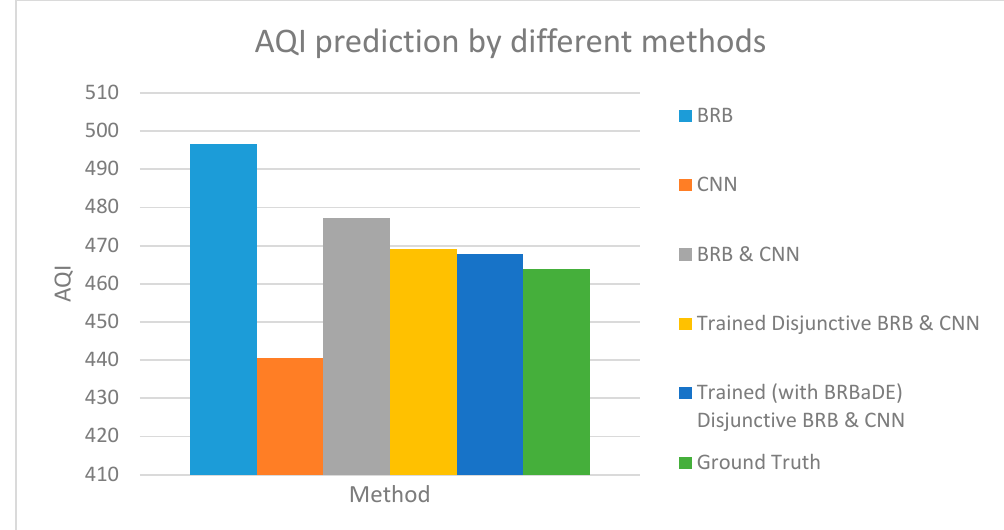
Figure 9. Air Quality Index (AQI) prediction by BRB, Convolutional Neural Networks (CNN), and our